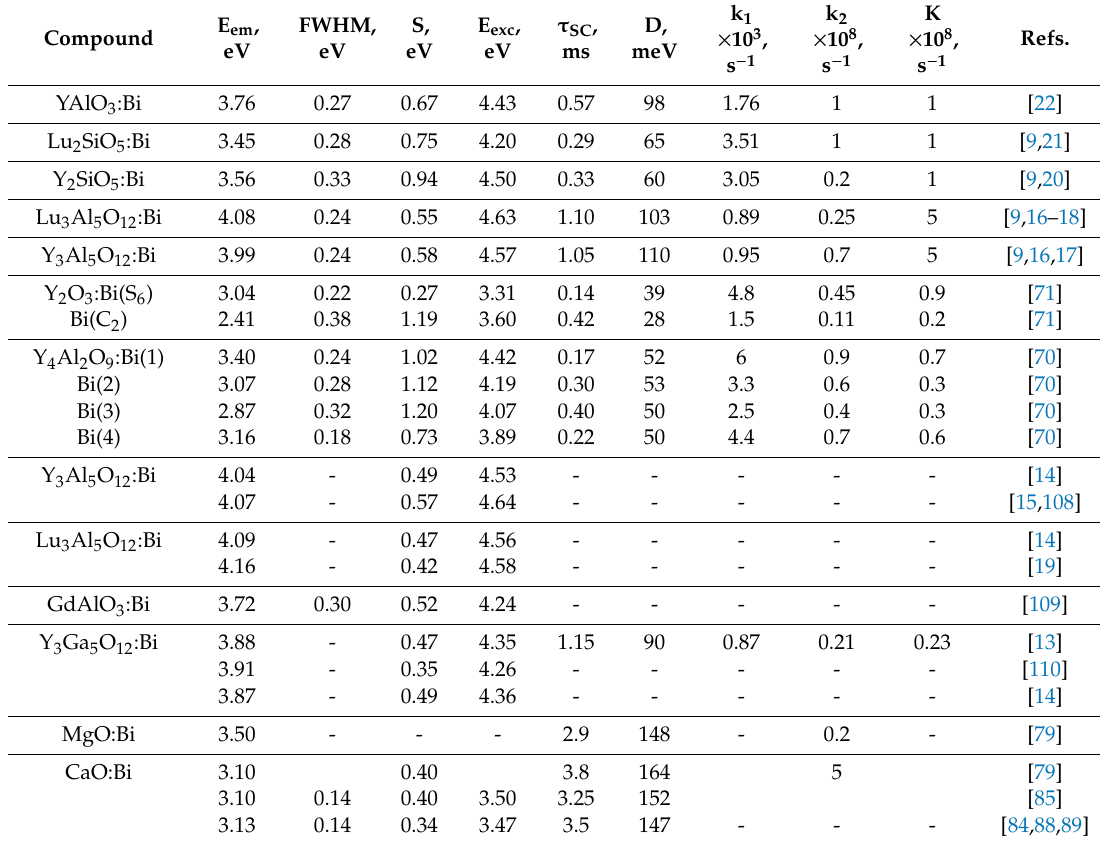
Table 1. Emission peak positions (E em ), full widths at half maxima (FWHM), the Stokes shifts (S), positions of the lowest-energy excitation band (E exc ), and decay times ( τ SC ) of the slow decay component obtained at 4.2 K for the triplet emission of Bi 3 + centers (denoted in this work the UV emission). The parameters of the triplet relaxed excited state (RES): the spin-orbit splitting energy (D), the probabilities of the radiative decay of the metastable (k 1 ) and emitting (k 2 ) levels of the triplet RES, and the zero-temperature nonradiative transition rate (K) between the metastable and emitting